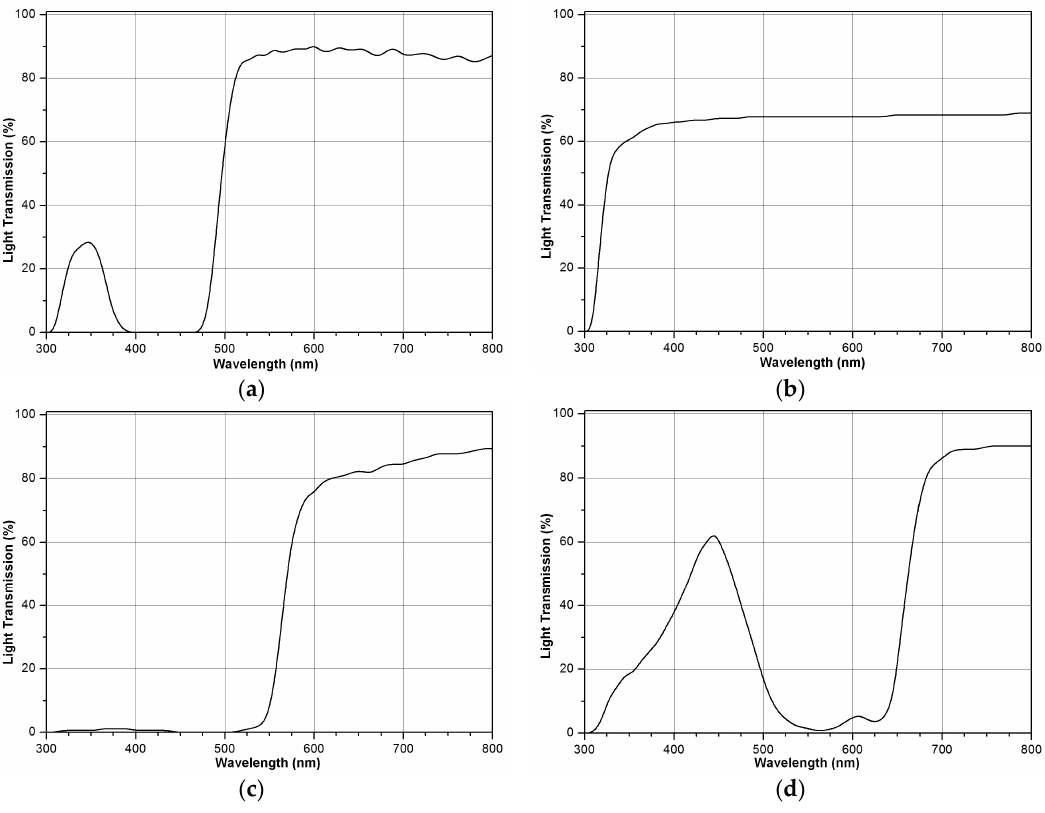
Figure 3. Spectral energy distribution curves of the secondary filters: ( a ) yellow; ( b ) frost; ( c ) amber; ( d ) lavender. The original names of the filters adopted by the manufacturer are, respectively: Medium Yellow, Hampshire Frost, Dark Amber, and Special Medium Lavender.